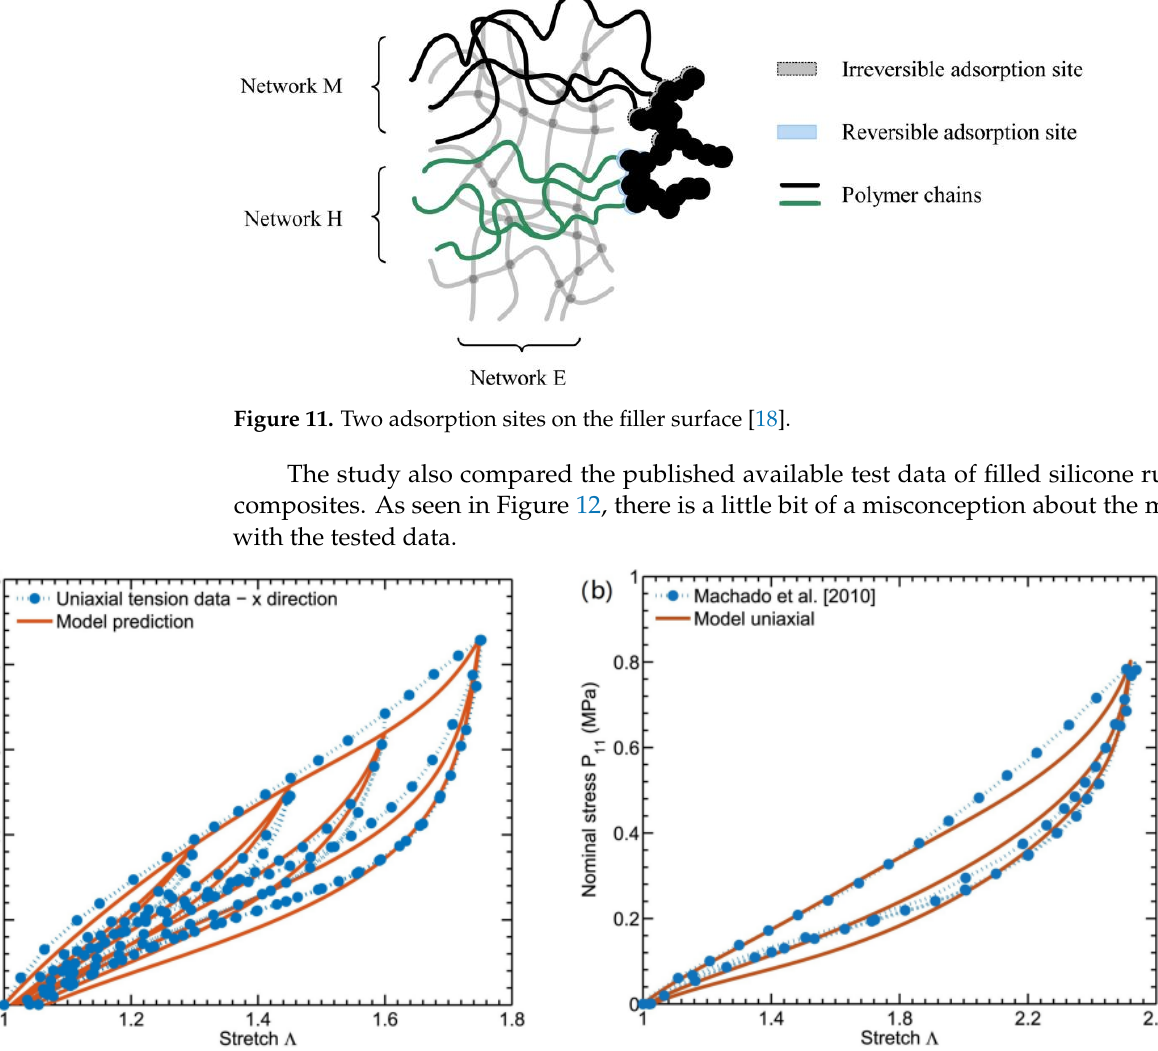
Figure 13. Rubber network is decomposed into three superposed chain populations [21].